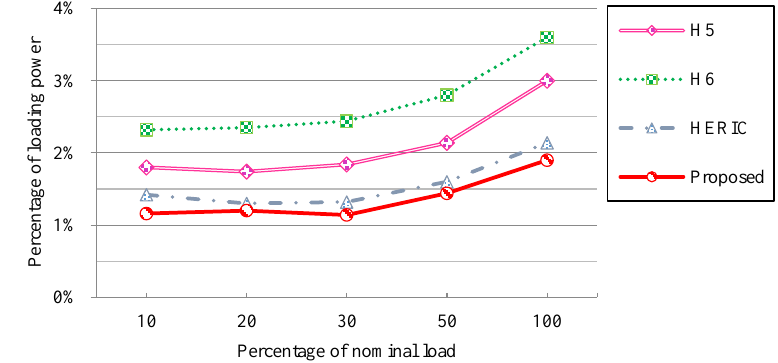
Figure 13. Total power loss through energy transmission.